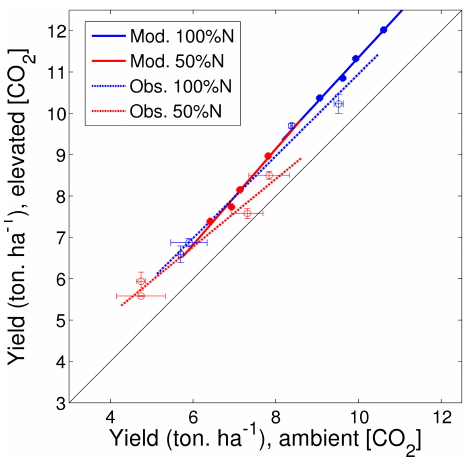
Figure 5. Effect of CO 2 fertilisation on observed and simulated grain yield, comparing wheat grain yields grown at elevated CO 2 ( ∼ 548ppm) with those grown at ambient CO 2 ( ∼ 378ppm). Sim- ulated yields are depicted by solid lines and filled circles, obser- vations are depicted by dashed lines and markers, shown for treat- ments with sufficient N fertiliser input (100%N, blue), and treat- ments that received half of that amount (50%N, red). Observations are from (Table 4 Weigel and Manderscheid,